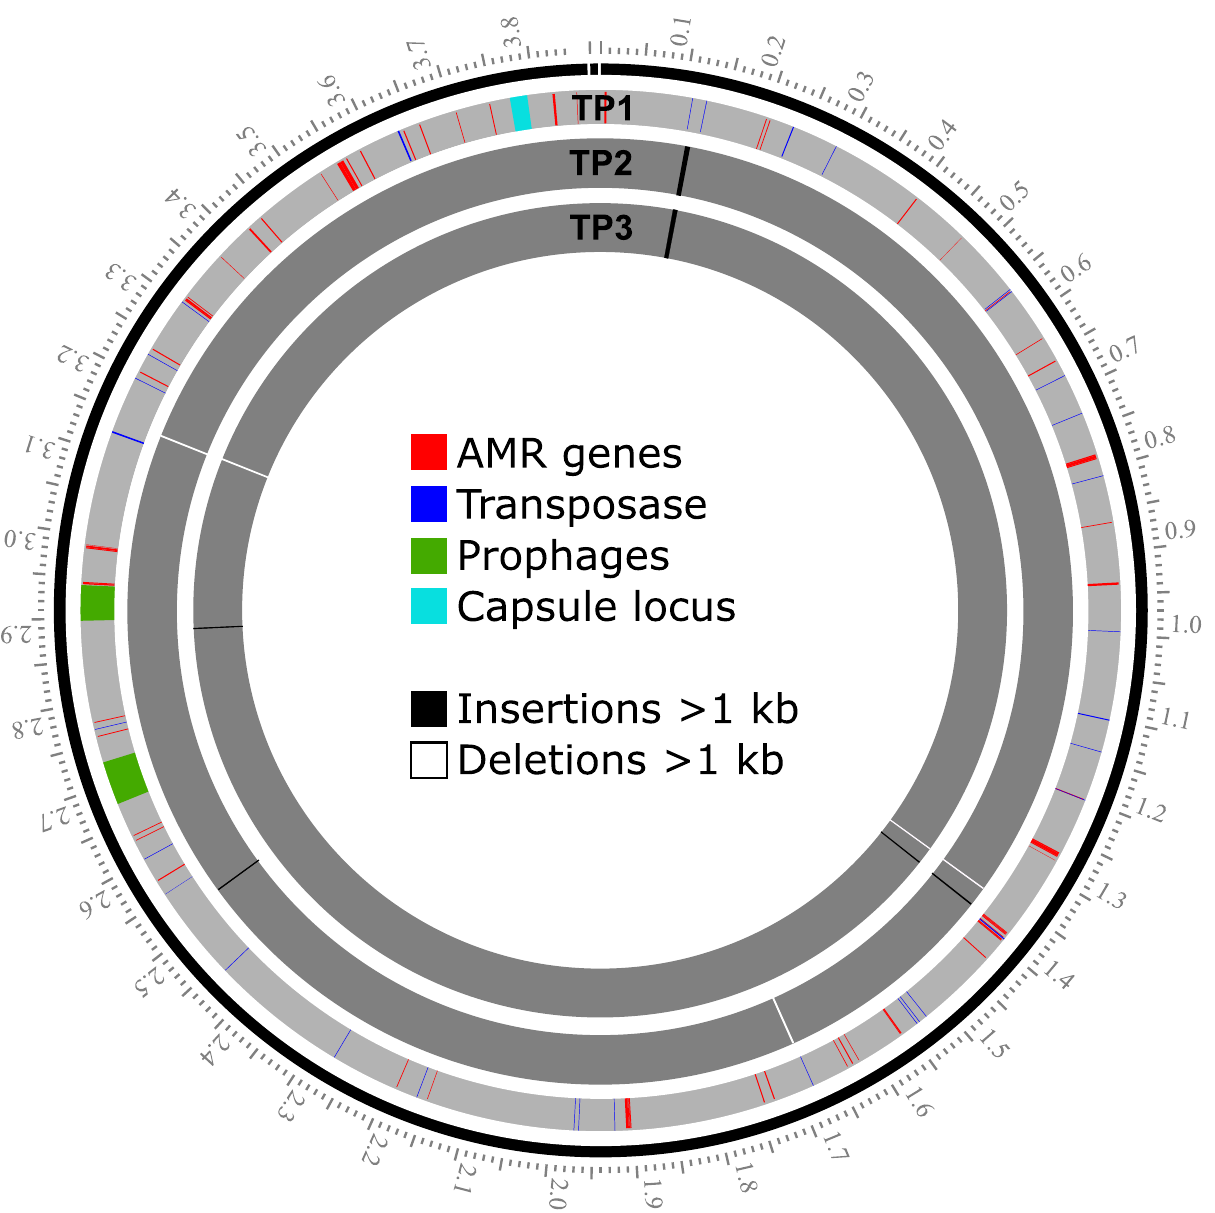
Fig. 4 Locations of AMR genes, transposases, prophages, and capsule locus in the TP1 genome, and large insertion and deletions (>1 kb) in TP2 and TP3, in reference to TP1. Each gray band represents a bacterial chromosome as labeled at the replication origin. The scale on the outer ring represents DNA coordinates in Mb. The locations of AMR genes, transposases, prophages and the capsule locus are indicated for TP1 only. Major insertions or deletions (>1 kb) are indicated in the TP2 and TP3 chromosomes. Of note, TP2 and TP3 contain a novel 6.7 kb insertion element at the ~0.11Mb position that is not present in TP1, indicating horizontal acquisition during